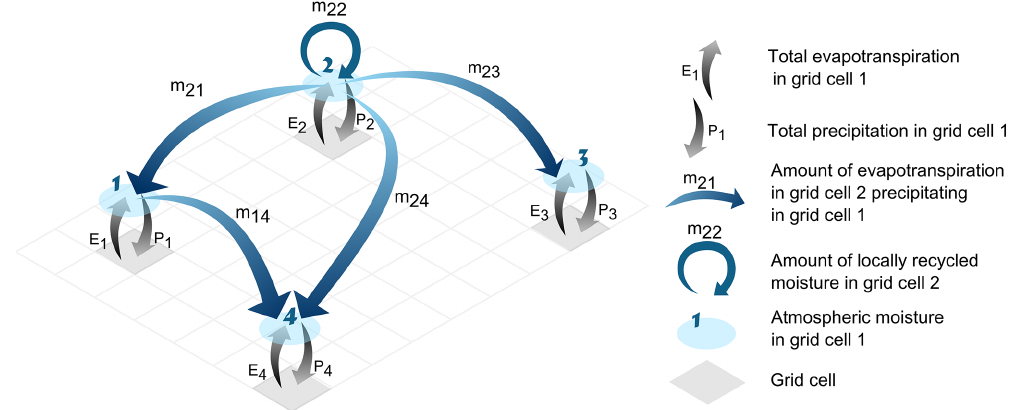
Figure 3. Schematic representation of the moisture recycling network. The exchange of moisture from 2 to 4 uses two alternative pathways: the direct one ( m 24 ) and the cascading pathway ( m 21 m 14 ). The grid cell 1 is an intermediary on an alternative pathway to the direct transport of moisture between 2 and 4. Thus, grid cell 1 forms a Middleman motif with grid cells 2 and 4.